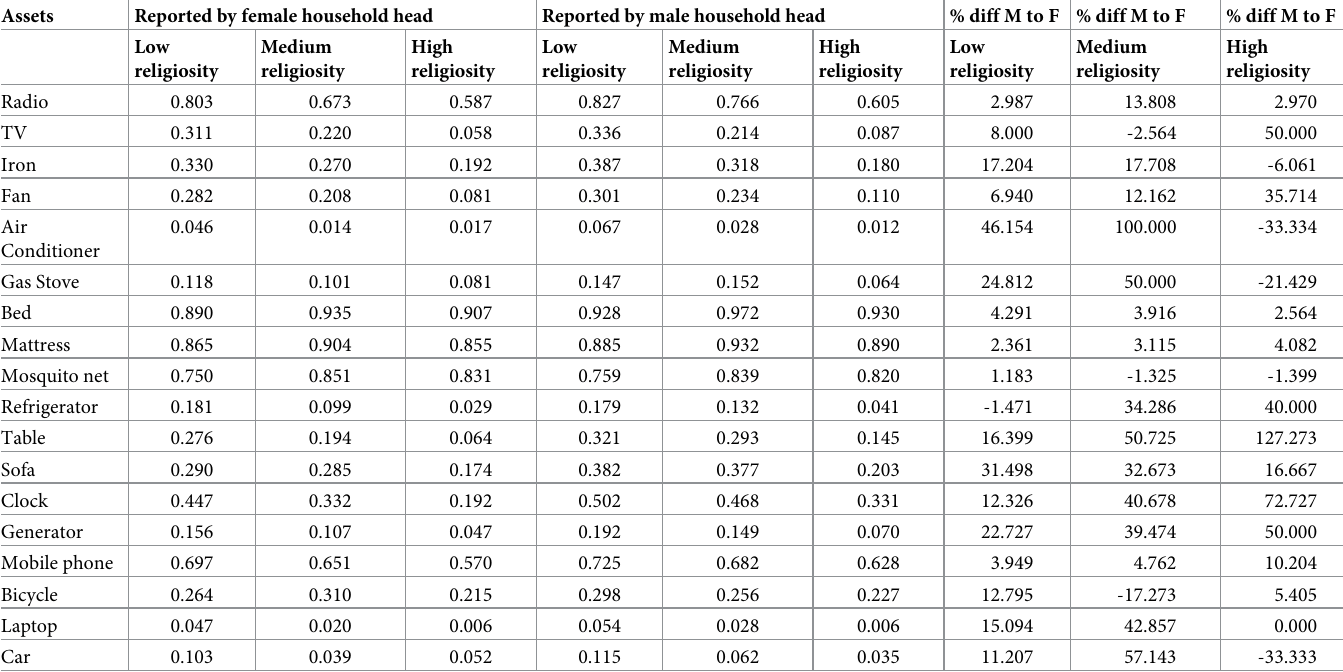
Table 4. Proportions of female and male household heads reporting ownership of selected items by degree of religiosity of the households. Assets